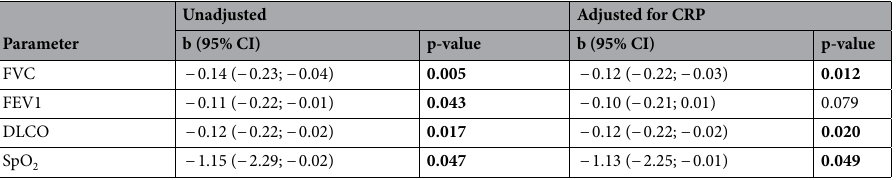
Table 3. Univariate and multivariate regression analysis predicting plasma Hsp90 levels based on lung function parameters, unadjusted and adjusted for CRP levels. FVC forced vital capacity, FEV1 forced expiratory volume in one second, DLCO diffusing capacity for carbon monoxide, SpO 2 oxygen saturation assessed by pulse oximetry, CRP C-reactive protein, b y intercept of a line, CI confidence interval. Statistically significant differences (p < 0.05) are marked in bold.